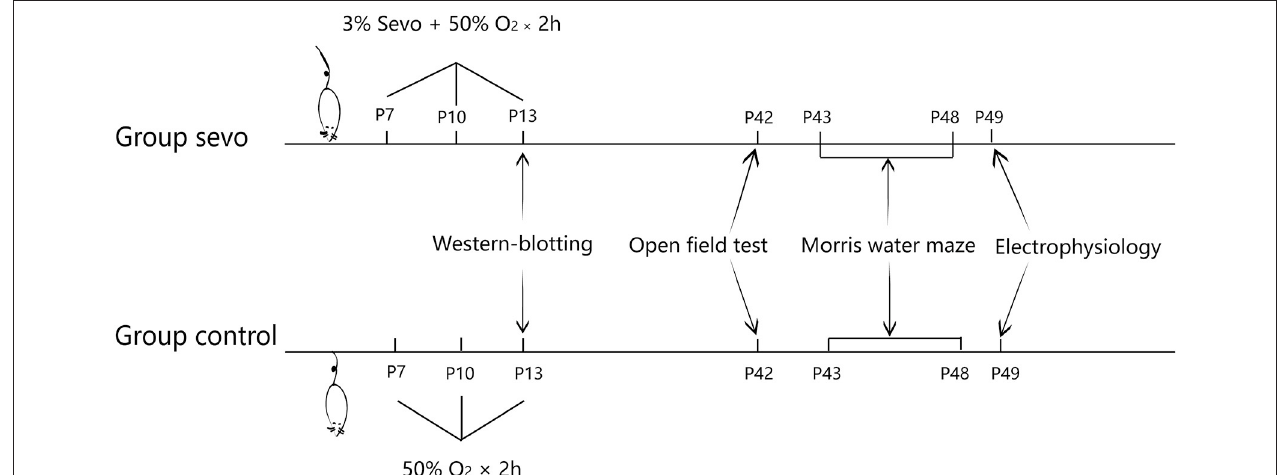
FIGURE 1 | Schematic timeline of the experimental procedure. surface of the water. White marks were located equidistantly around the edge of the maze in all start positions. On P43, each rat was allowed to swim freely in the pool for 60 s for habituation. From P44 to P47, a hidden escape platform (10 cm in diameter) was submerged 0.5 cm below the surface of the water in the middle of the target quadrant. During navigation training, four trials separated by 30 s were conducted daily for each rat. Each day, rats were placed into four different starting quadrants, and entry from the north, south, east, or